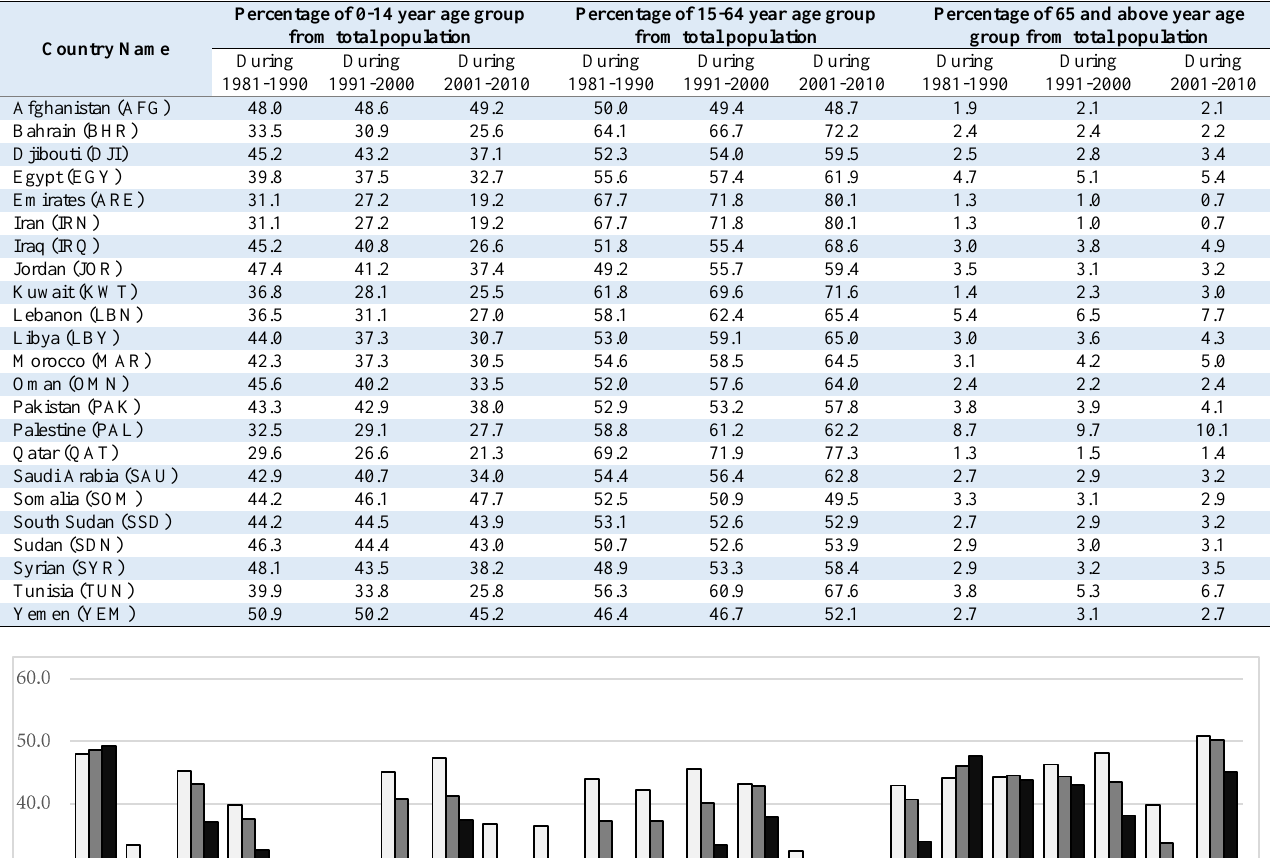
Table 1. The average percentage of each age group in each country during the last three decades (1981-2010) Country Name Afghanistan (AFG)